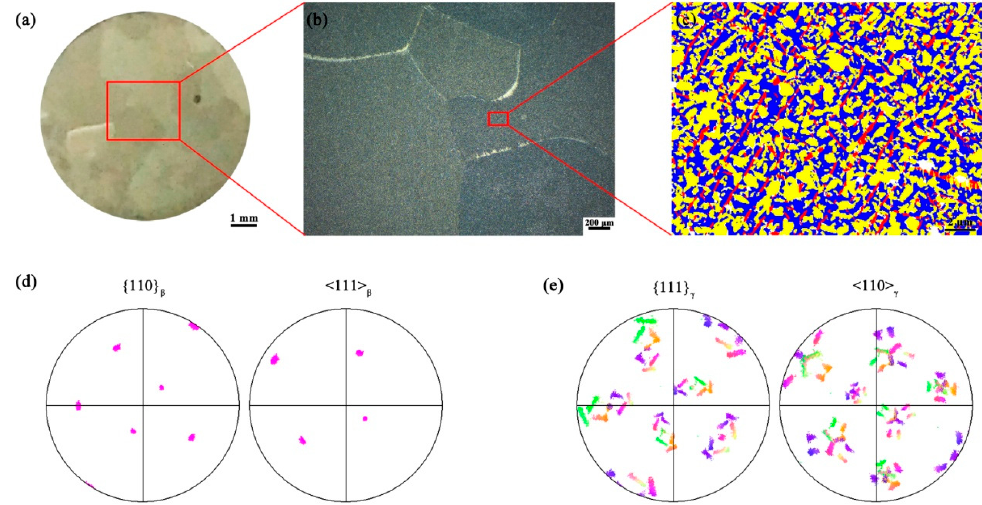
Figure 2. ( a ) Macrostructure of the etched cross-section of the sample prior to compression; ( b ) Optical image of the Q&T microstructure. The ultra-large β grains can be clearly observed; ( c ) A local phase map with a dimension of 20 × 15 μ m reveals that the microstructure consists of three phases: β in blue, α 2 in red and γ in yellow; ( d , e ) are the pole figures for β and γ phase, respectively. Note that a Kurdjumov-Sachs (K-S) orientation relationship is evident.